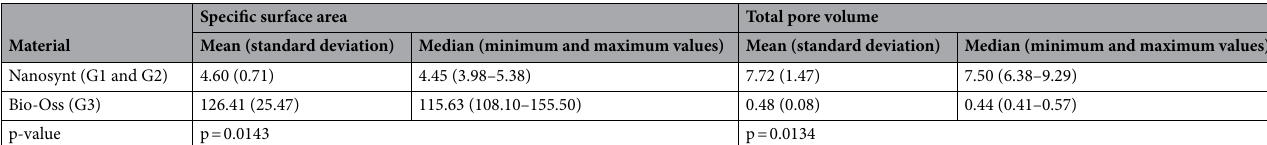
Table 1. Mean (standard deviation), median (minimum and maximum values) of the specific surface area (m 2 /g) and total pore volume (cm 3 /g) of the materials studied (n = 3).